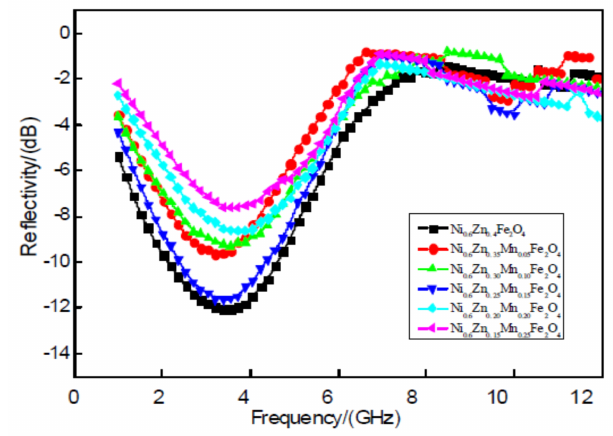
Figure 8. Curves of reflectivity and frequency for the Ni 0.6 Zn (0.4 − x) Mn x Fe 2 O 4